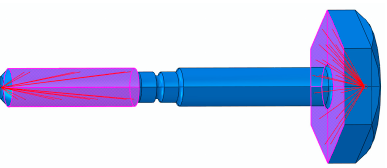
Figure 4. Notch bolt’s fixing surface and load surface diagram.